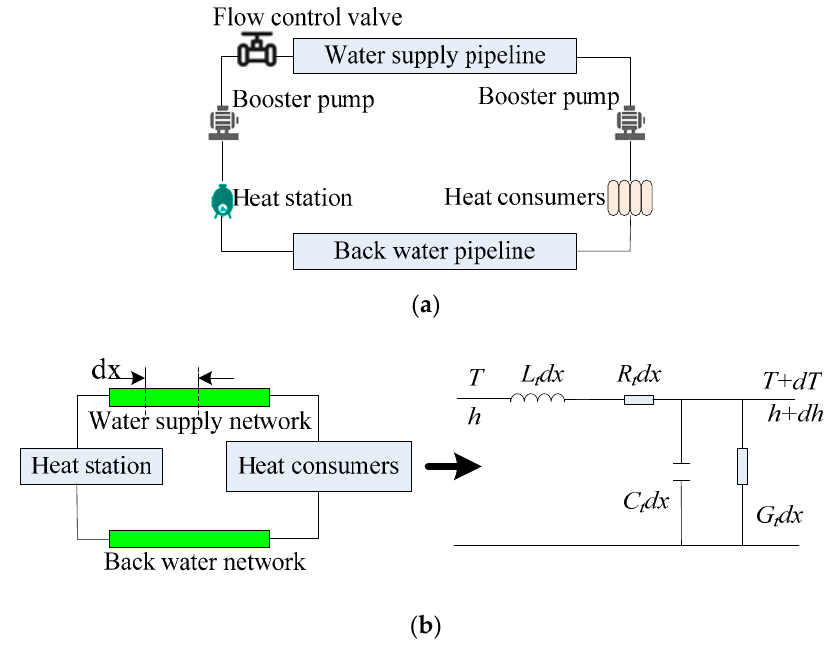
Figure 1. Heating pipeline model: ( a ) Schematic diagram; ( b ) Distributed-parameter thermal circuit model.